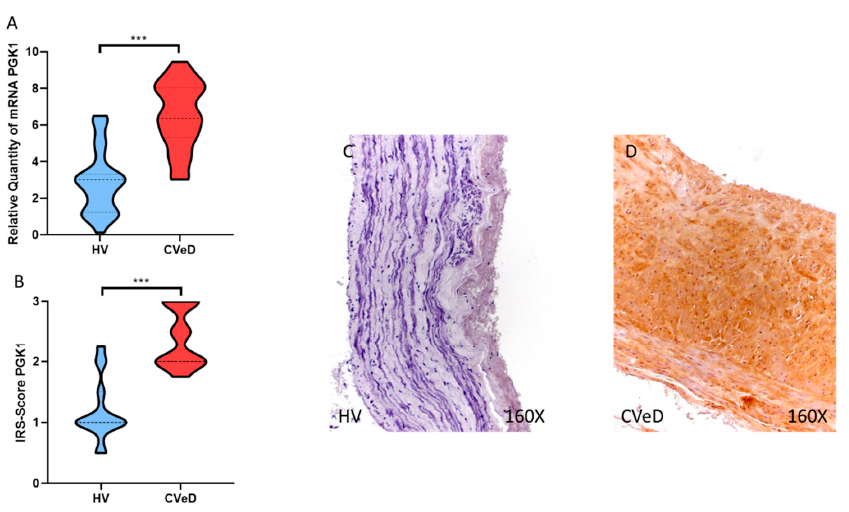
Figure 2. ( A ). PGK1 mRNA expression in the HV group (healthy controls) and CVeD patients (chronic venous disorder). ( B ). IRS-Scores for PGK1 in the venous wall of the HV group and the CVeD group. ( C – D ). Images showing the immunostaining for PGK1 in the C group in the three tunicae of the venous wall. p < 0.001 (***).